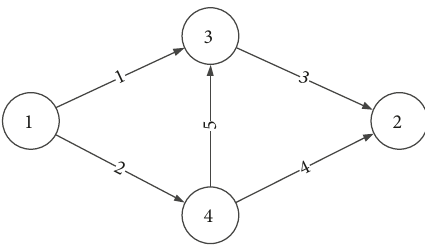
Figure 1: Schematic of a network with four nodes and five links.